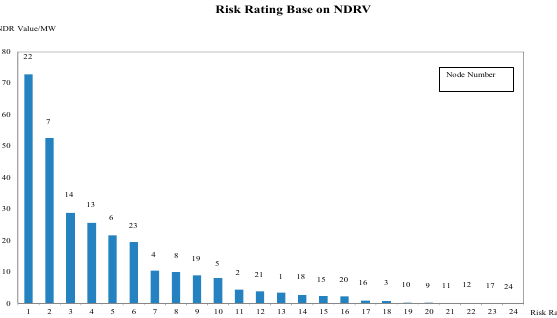
Figure 6. Diagram of the risk rating based on the node disconnection risk valuation (NDRV) in the RTS-79 system.